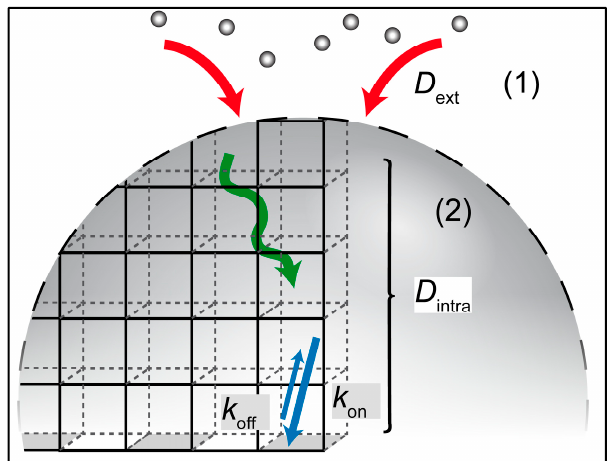
Figure 5. Illustration of the mass transport during loading: (1) external diffusion of fluorescein molecules towards the nanoparticles as described by the Adam and Delbrück model; (2) Concurrent intracrystalline diffusion and adsorption/desorption to/from the internal surface of the MOF NP (reaction-diffusion).